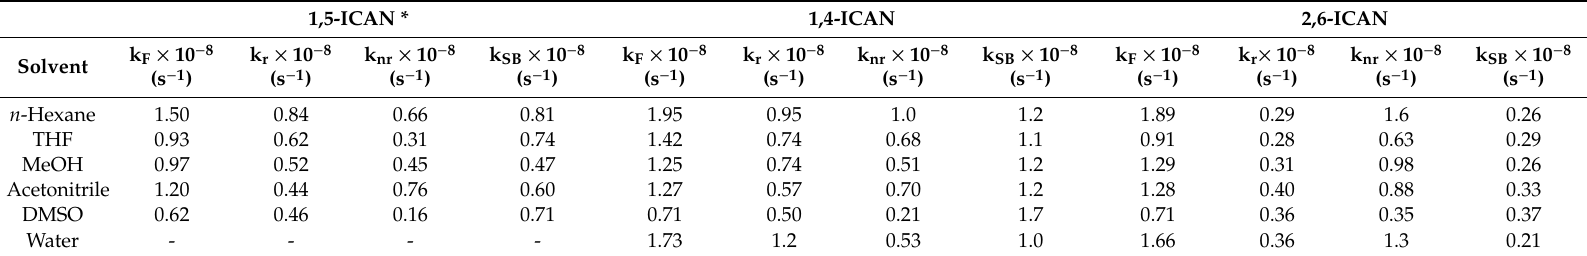
Table 4. The fluorescence decay rate (k F ), the radiative decay rate (k r ), the non-radiative decay rate (k nr ), and the radiative decay rate (k SB ) calculated by the Strickler–Berg equation (Equation (5)) for the ICAN isomers.